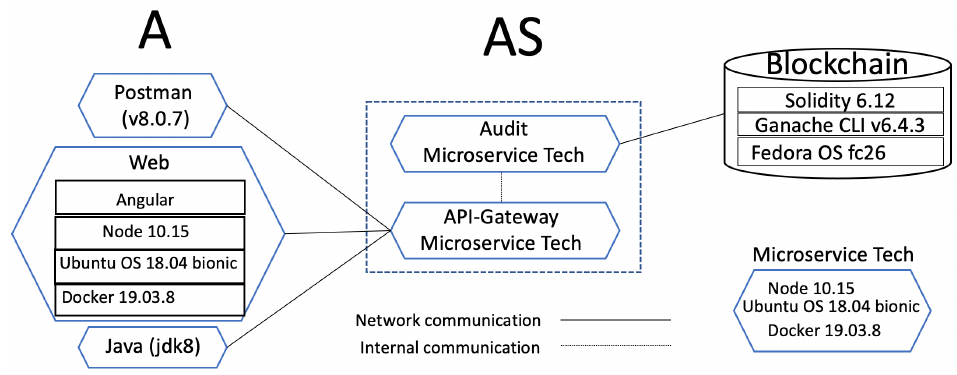
Figure 7. Technologies implemented in the